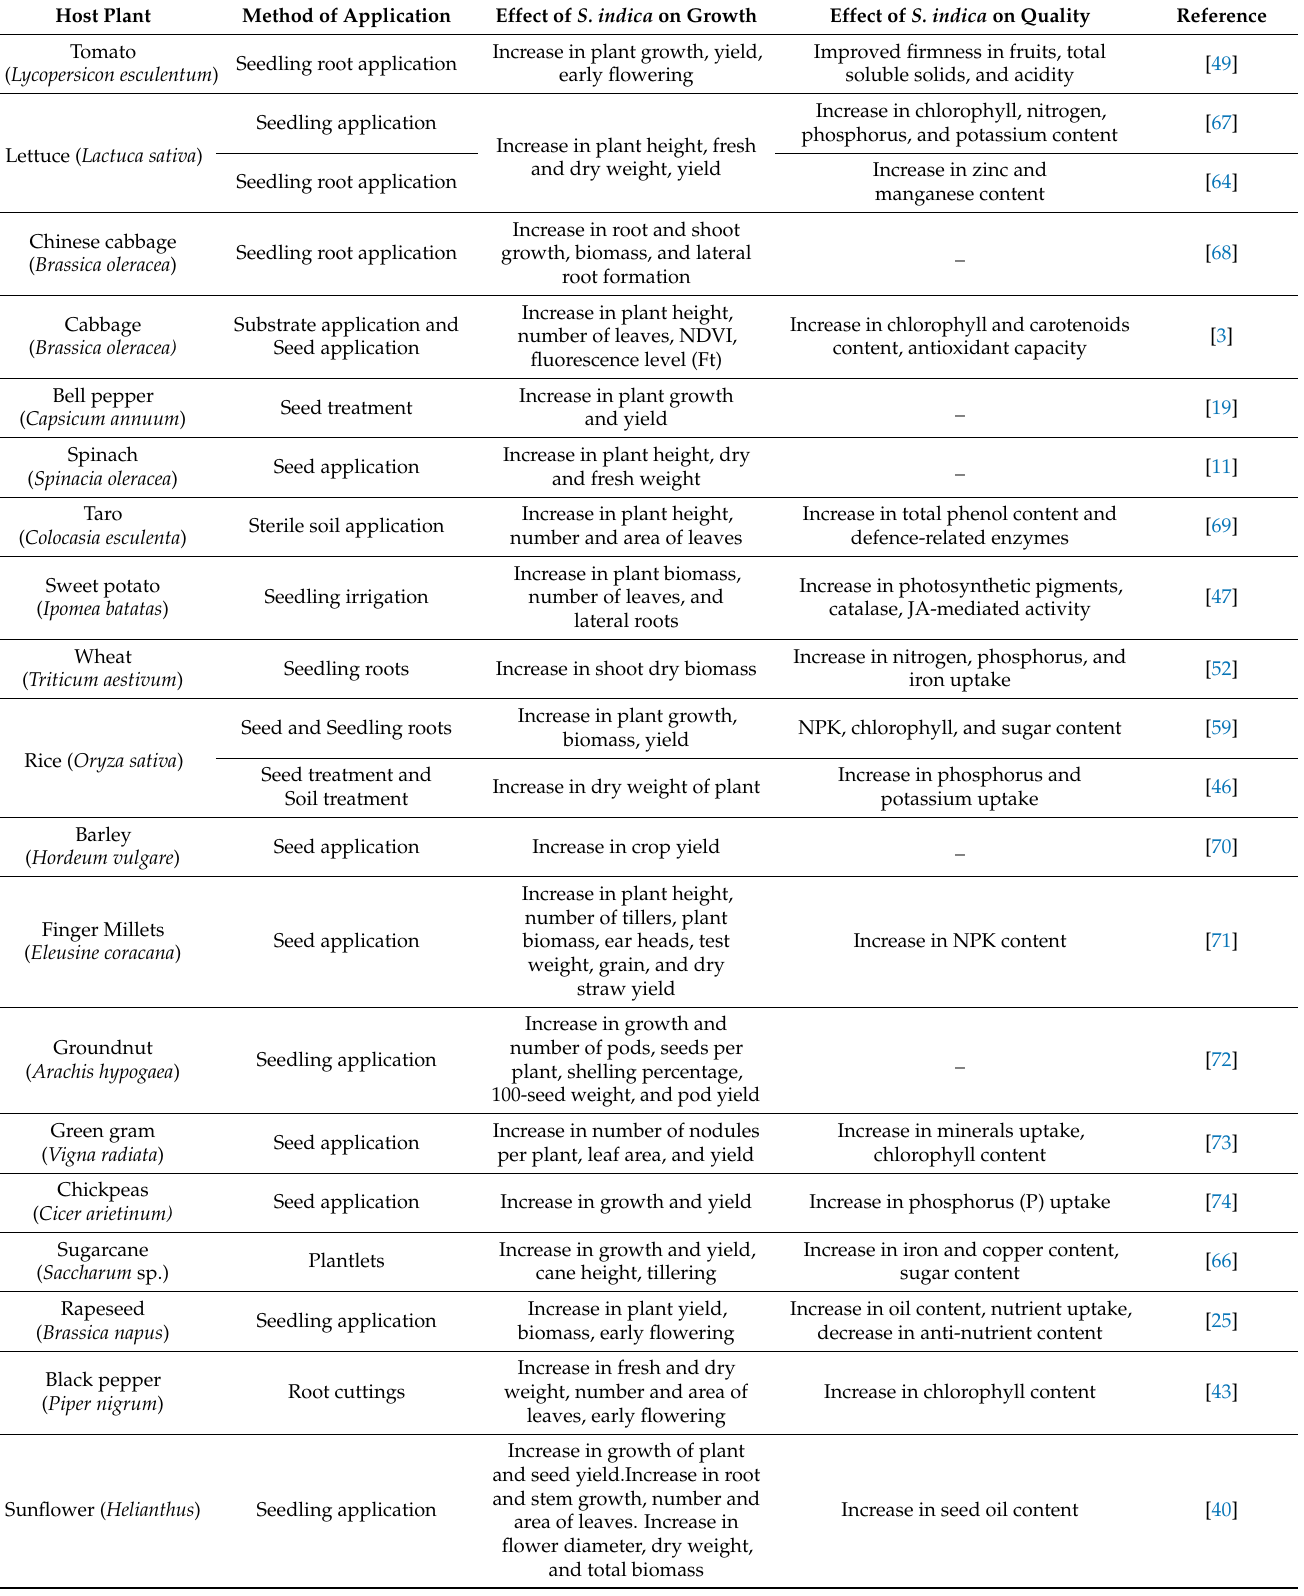
Table 1. Effects of S. indica on growth and quality of host